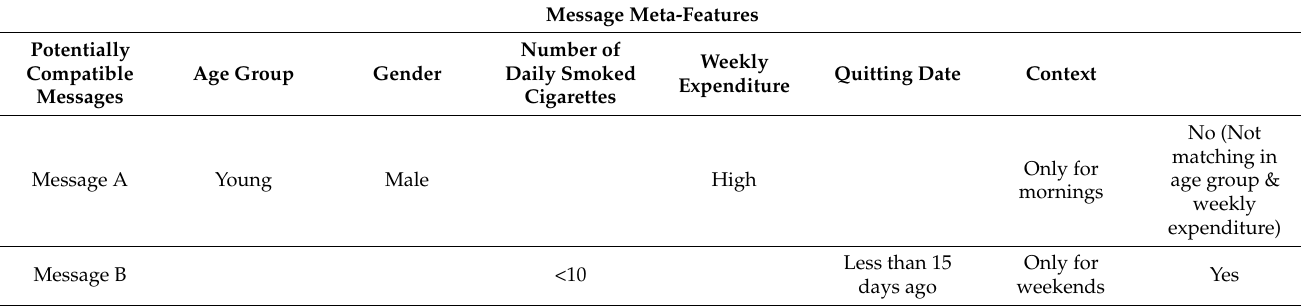
Table 1. Example of how the KBA processes message compatibility for a given